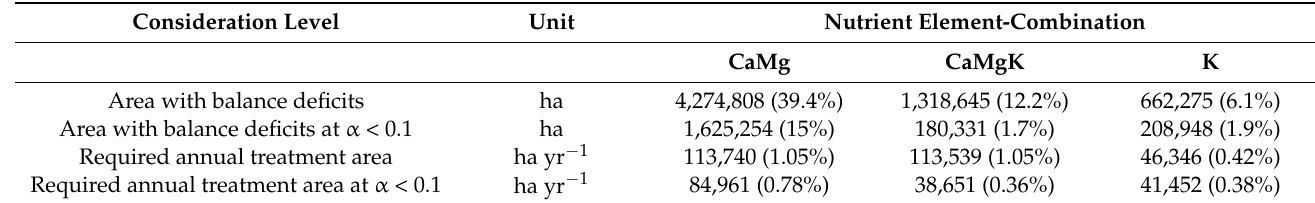
Table 3. Areas with balance deficits for element combinations Ca and/or Mg, Ca and/or Mg and K and only K for the total forest area of Germany assuming harvest intensity REAL. Presented are all sites with balance deficits and those where balance deficits are at α < 0.1